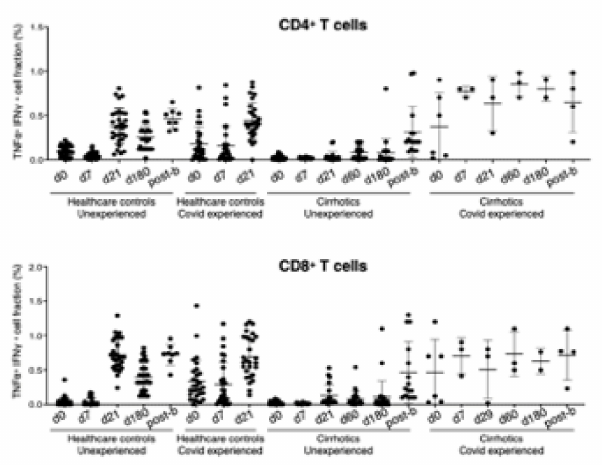
Figure 3. Flow cytometry assessment of total and plasma antigen-specific B cells in peripheral blood mononuclear cells (PBMCs) from HW and cirrhotics patients.